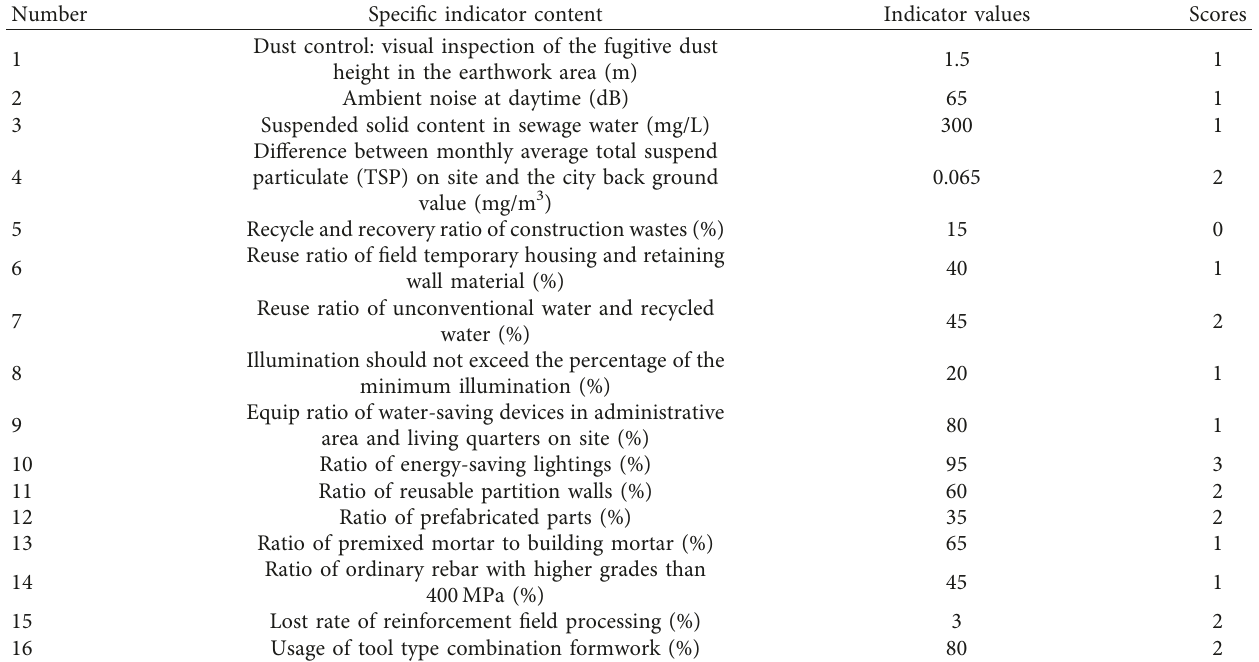
Table 9: Evaluation result.